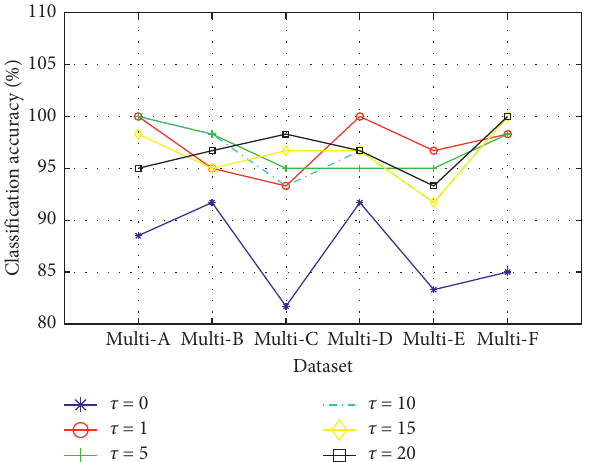
Figure 8: Effect of τ on classification accuracy.